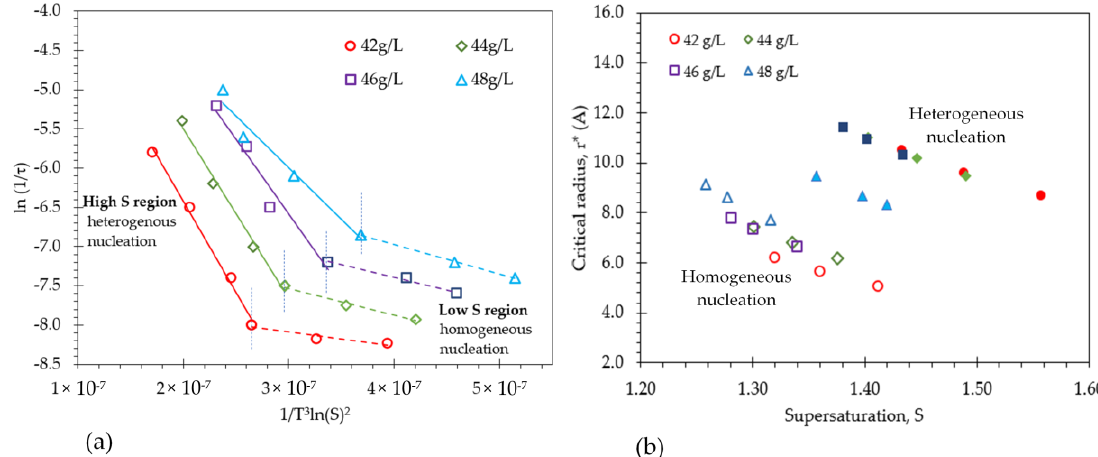
Figure 5. Isothermal crystallisation of L-isoleucine at 5 V: ( a ) nucleation time of solutes in high solution supersaturation and low solution supersaturation, showing that the associated nucleation mechanisms took place in the solution during crystallisation, with the regions marked by vertical dash lines and ( b ) critical nuclei radius, r*, formed at high supersaturation (closed markers) and low solution supersaturation (open markers) for solution concentrations of 42 g/L–48